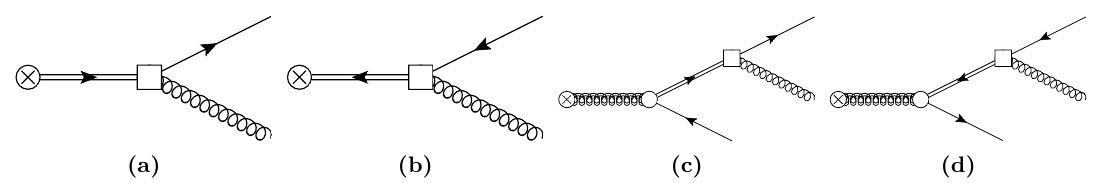
Figure 5. Diagrammatic representation of the new terms due to the sNMGF in the expansion of the fields in (4.7). The new interaction vertices due to the sNMGF are represented by white blocks instead of blobs. (a) and (b) are O ( g 0 ) and represent χ ∗ O ( g 2 ) and collectively represent F ∗ 0